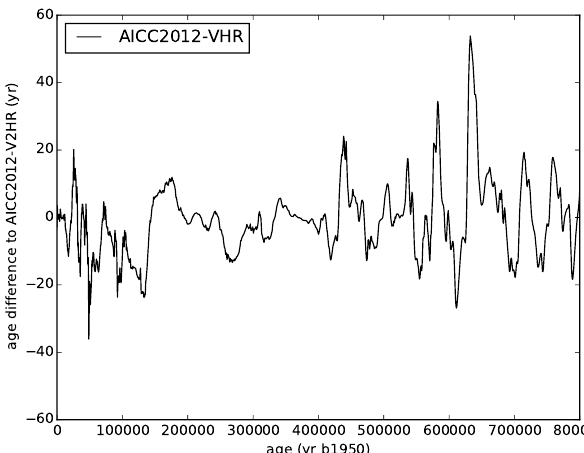
Figure 3. Sensitivity of the AICC2012-like experiment to a change of resolution of the correction functions. The black line is the age difference between the AICC2012-V2HR and AICC2012-VHR ex- periments (see